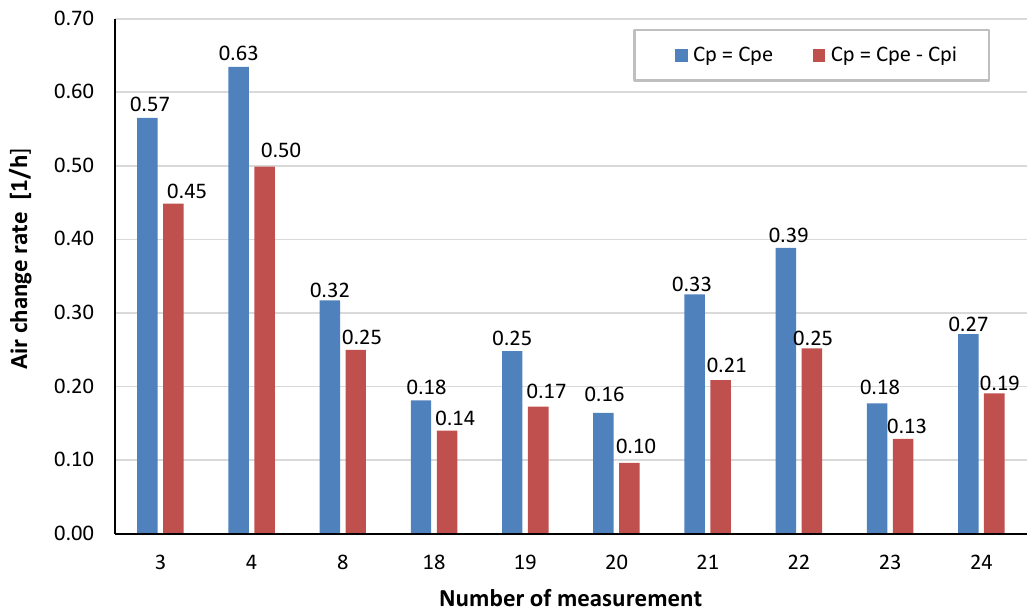
Figure 8. The values of air change rate without considering the influence of the openings C p = C pe and when considering the effect of the openings C p = C pe − C pi for higher wind speed v = 4.4 m/s–10.3 m/s.